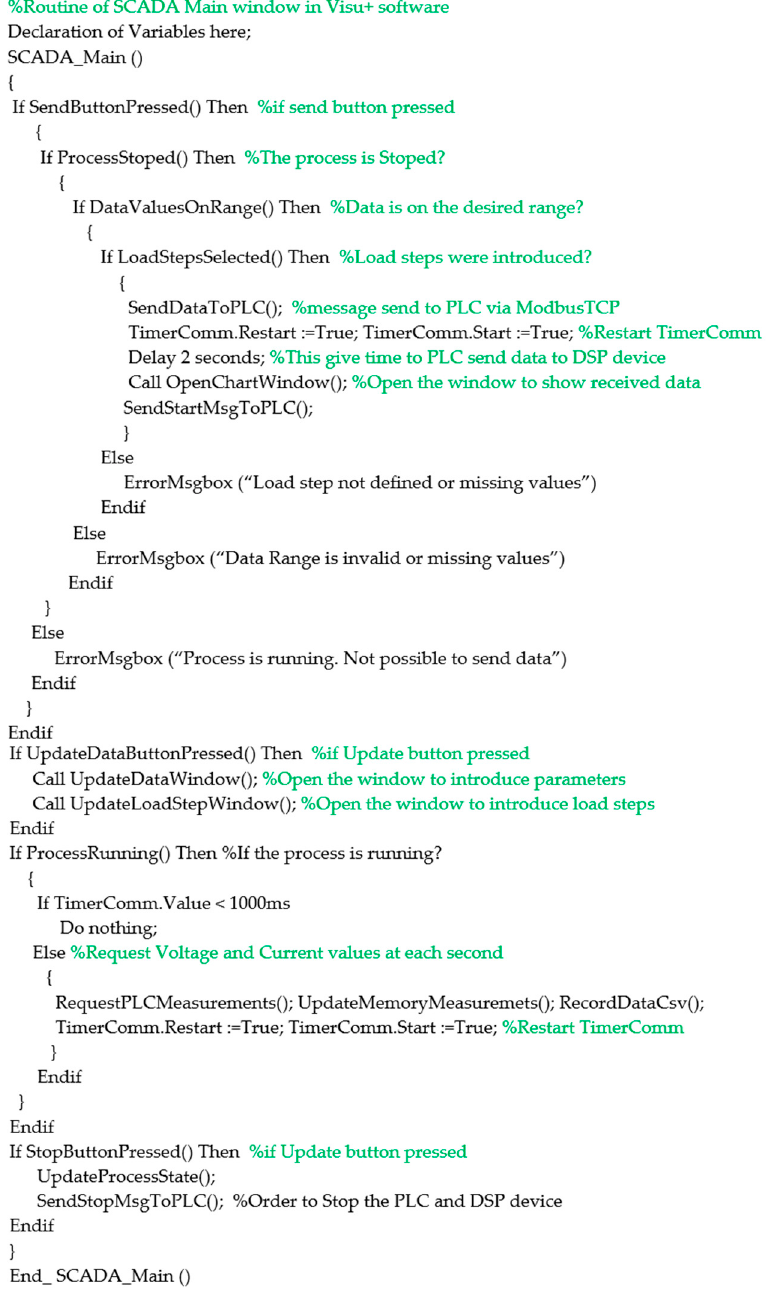
Figure 21. Simplified pseudocode of the main window of SCADA software in C code.